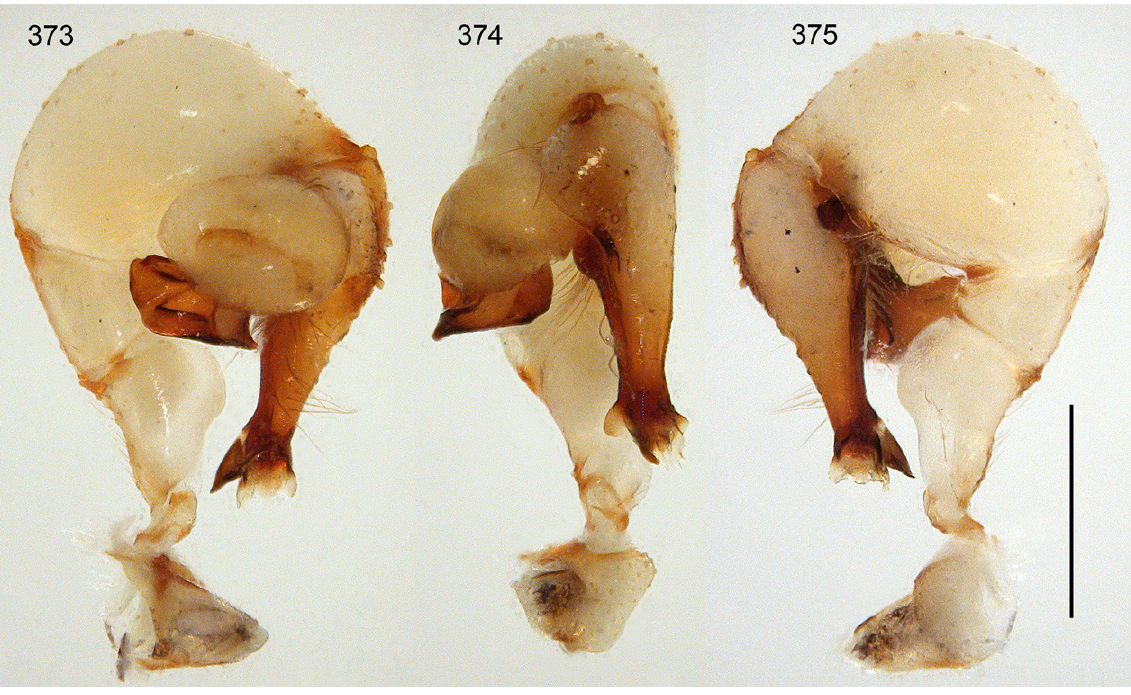
Figs 373–375. Crossopriza illizi sp. nov.; male from Algeria, Iherir (CRB); left palp, prolateral, dorsal, and retrolateral views. Scale bar = 0.5